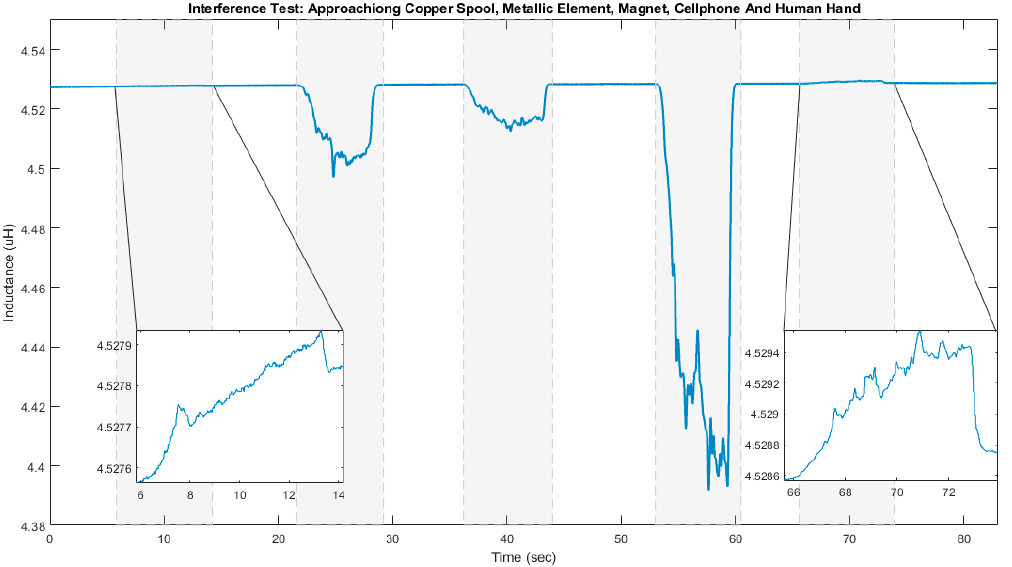
Figure 8. Inductance values ( µ H) recorded from the interference test, where a copper spool, a metallic element, a magnet, a cellphone, and a human hand were moved towards the inductive sensor’s coil. In each case, the periods of moving objects toward the coin are highlighted in grey shade.